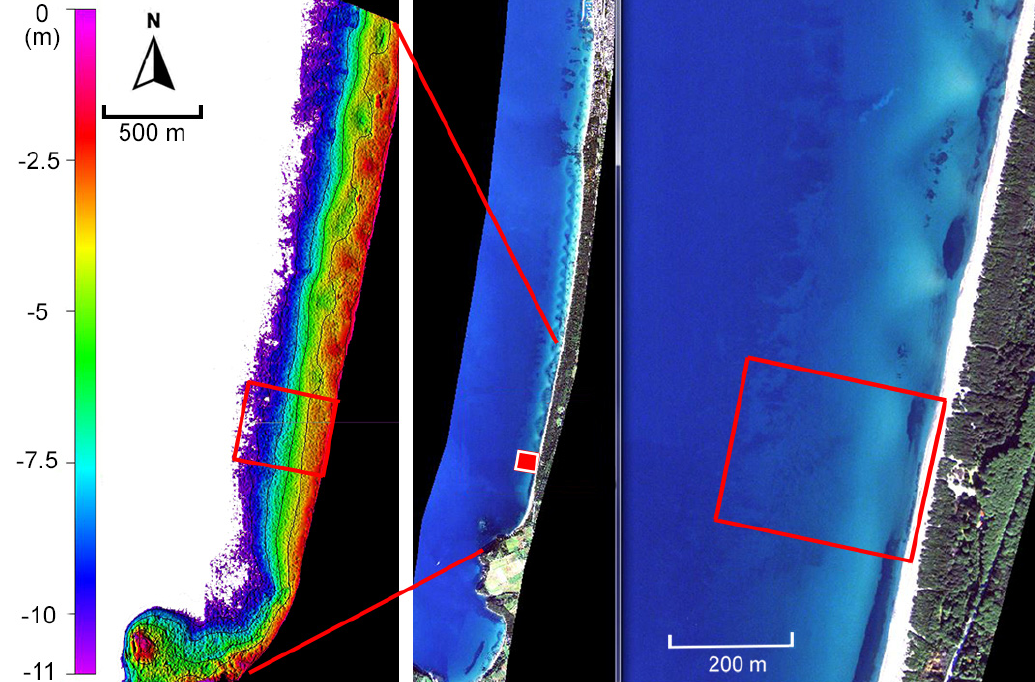
Figure 2. Satellite-Derived Bathymetry (SDB) and the WorldView-2 (WV2) RGB image showing the study area position.